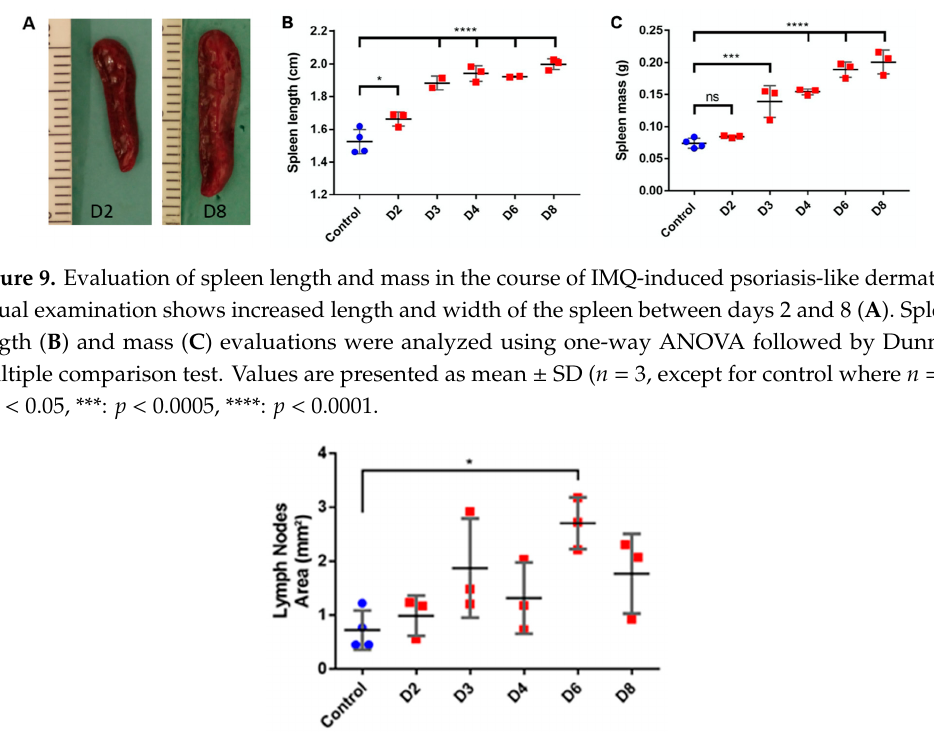
Figure 11. Immunofluorescent staining of germinal centers in mice inguinal lymph nodes. Sections were stained with anti-mouse IgD (BioLegend) to detect B cells follicles (green), and with biotinylated peanut agglutinin (PNA) (Vectors Laboratories) to detect germinal centers (red). Scale bar = 500 μ m. 4. Discussion Despite the development of numerous preclinical models to assess the different aspects of topical and transdermal delivery, the complexity of skin barrier in terms of structure and composition remains a limiting factor for drug penetration, even in diseased skin [38,39]. The IMQ-induced psoriasis mouse model recapitulates several features of skin inflammatory diseases similar to human psoriatic inflammation. These characterized features include increased thickening of the epidermal layer, elongation of rete-like ridges and hyperkeratosis after IMQ treatment. Our study showed all these parameters which are in agreement with previous studies [4,6,37]. For the first time, this study focuses on monitoring the quantity of IMQ found in the skin following its topical application. The molecule is detected in skin after two days of daily application and its concentration increased three folds on the day 6 of experimentation. This kinetic of penetration and retention can be explained by the physical and chemical properties of IMQ. The low molecular weight (240.3 g/mol) allows an easy skin penetration but due to its lipophilic properties (logP = 2.6) the molecule is mainly retained in the stratum corneum. The increase in skin drug concentration is related with skin changes that appeared from day 2 to 3. The total PASI score highlights the psoriasis